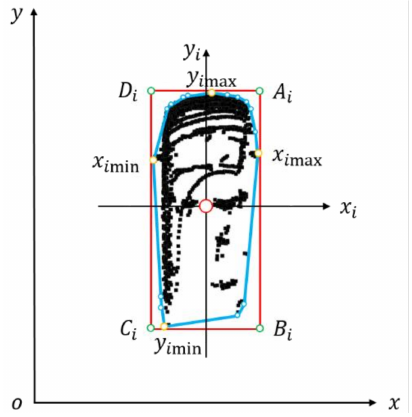
Figure 6. Illustration of the Basic Line algorithm. The black points represent the projection points of the original point cloud on the horizontal plane, the blue points represent the convex hull points, the blue lines represent the contour lines of the point cloud, and the yellow points represent the poles of the convex hull points in the x and y directions. The green points represent the corner point of the two-dimensional bounding box, and the red lines represent the extracted two-dimensional bounding